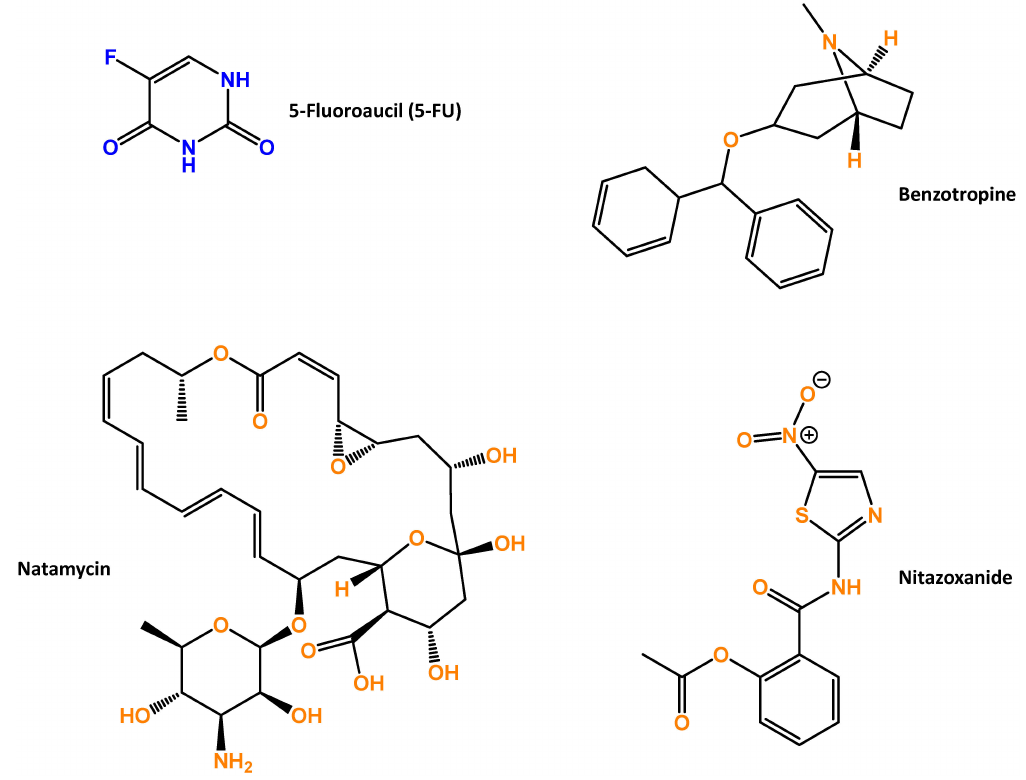
Figure 1. The chemical structures of drugs used in this